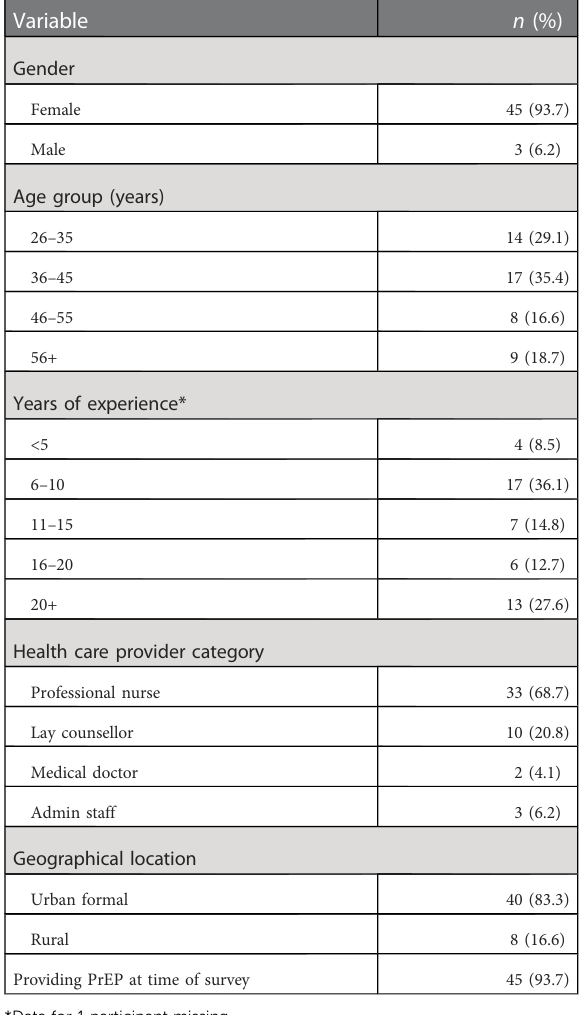
TABLE 1 Demographic characteristics of the sample of health providers ( n